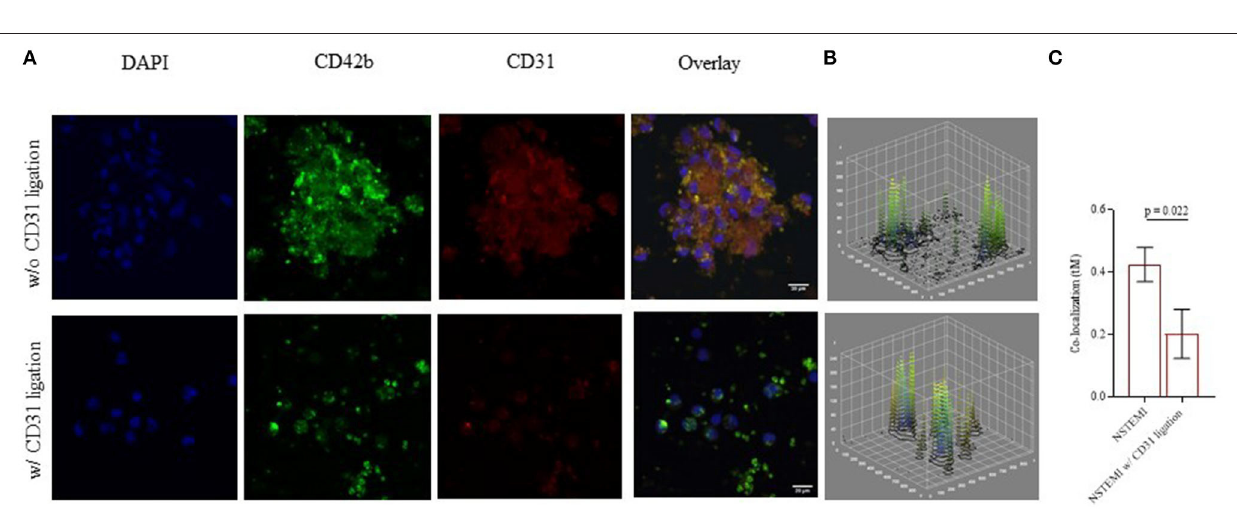
FIGURE 7 | Monocyte-platelet binding at confocal microscopy. Immunofluorescence confocal microscopy images (512 × 512 pixels of resolution, scale bar 20 µ m) showing monocyte-platelet (Mo-Plt) binding before and after the CD31 ligation. (A) A representative patient with NSTEMI; (B) 3D plots showing display the changing in Mo-Plt binding after the CD31 ligation; (C) Mo-Plt co-localization within NSTEMI group ( n = 5). The degree of co-localization was quantified by using a Mander’s overlap coefficient (MOC) ( µ m = micrometer; NSTEMI, Non-ST-Elevation Myocardial Infarction; w/, with, w/o,